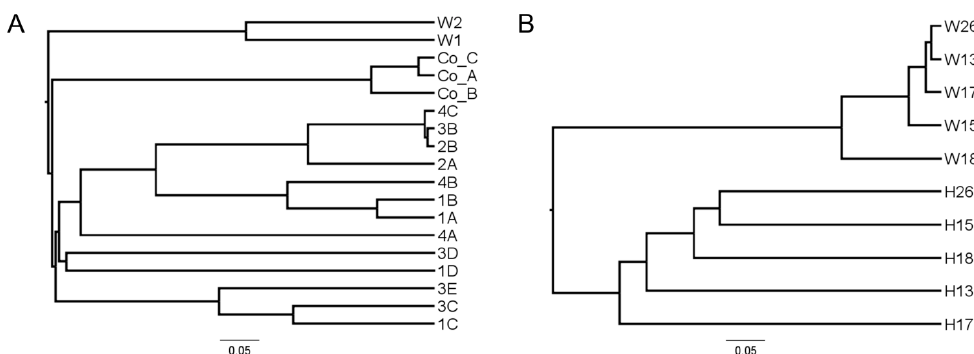
Figure 1. Comparison of microbial communities from A. elisabethae and seawater using the Yue and Clayton dissimilarity calculator: ( A ) V1/V2 dataset subsampled to 2200 sequences/library; and ( B ) V4 dataset subsampled to 2600 sequences/library. Dendrograms were prepared using the UPGMA algorithm.